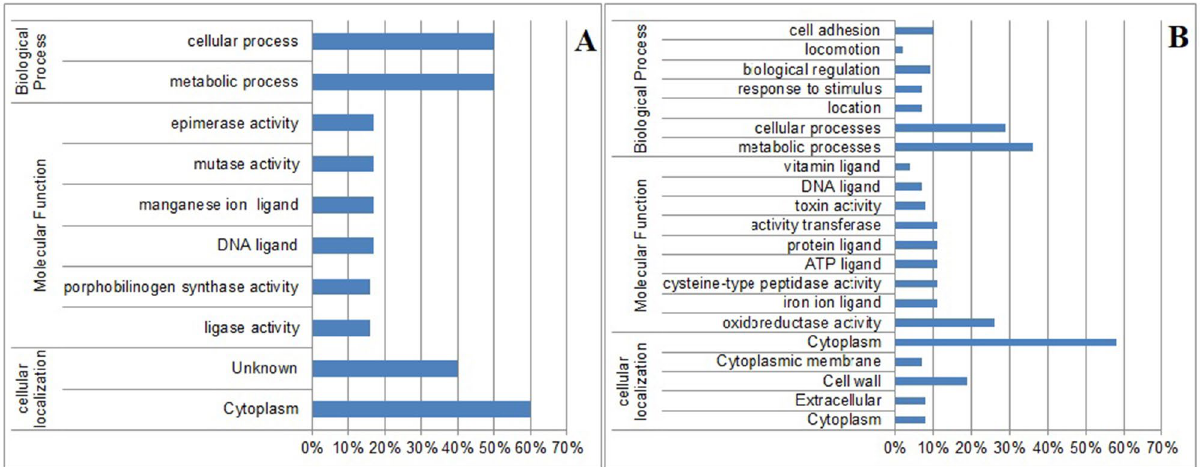
Figure 2. Distribution of proteins according to biological processes, molecular function, and cellular localization. ( A ) Distribution of the exclusive proteins of the ICC-45 strain. ( B ) Distribution of the proteins shared between strains ICC-45 and NAP1/027 (LIBA5756). These C. difficile proteins were identified based on the annotations of the ontology gene (GO